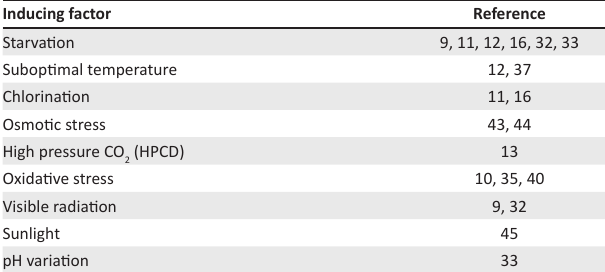
TABLE 3: Inducers of viable but non-culturable state in Escherichia coli